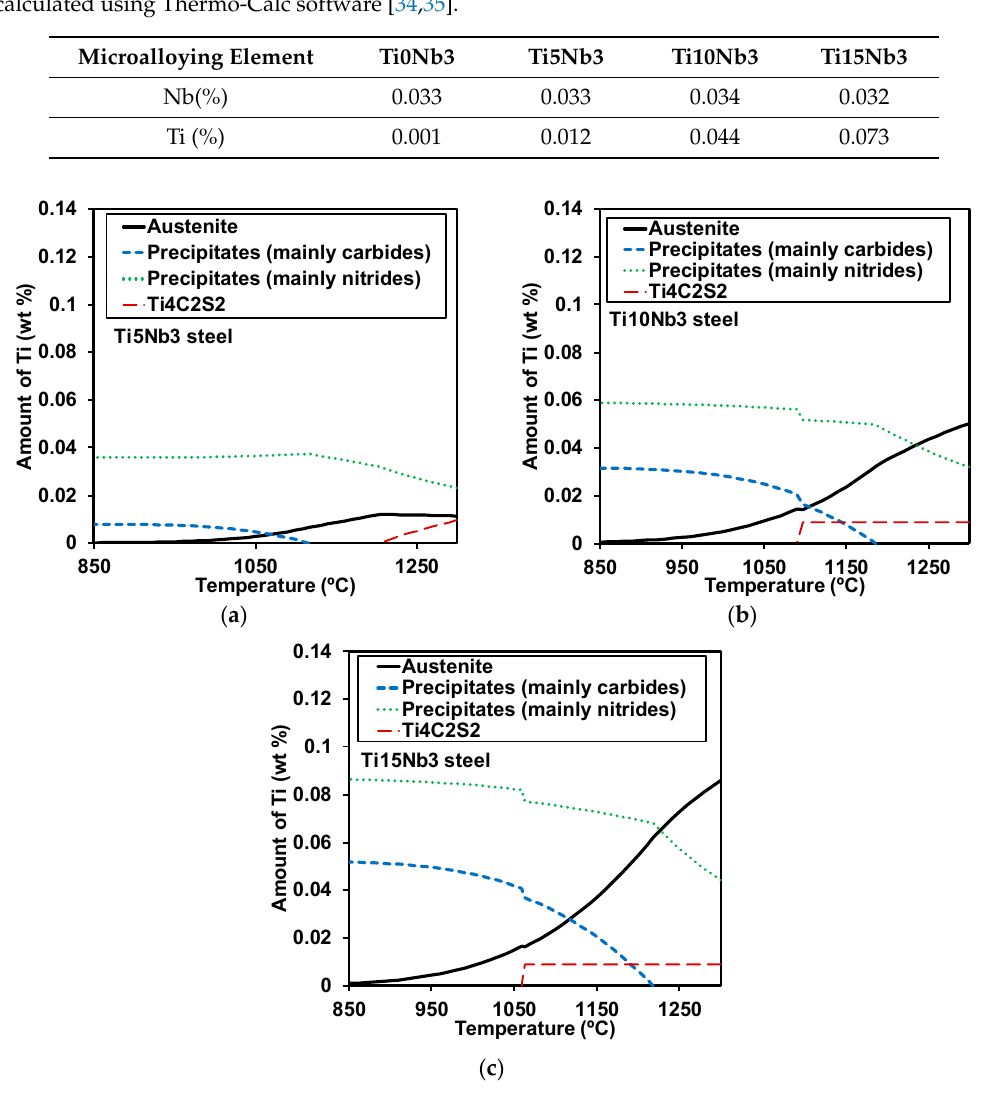
Figure 15. Amount of Ti (wt.%) in each of the phases at equilibrium conditions calculated with Thermo-Calc software [34,35] for the high Ti steels. ( a ) Ti5Nb3, ( b ) Ti10Nb3, ( c ) Ti15Nb3.